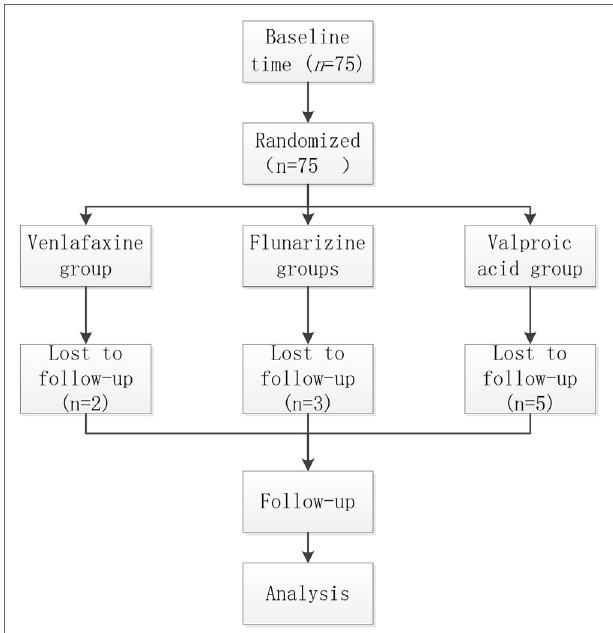
FiGUrE 1 | CONSORT flow diagram of patient